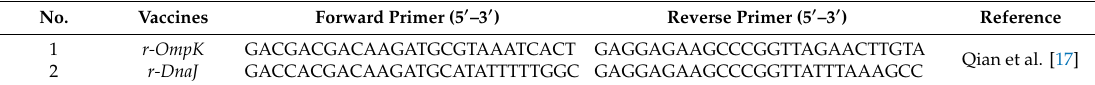
Table 2. Recombinant cell vaccine sequences for r-OmpK and r-DnaJ .